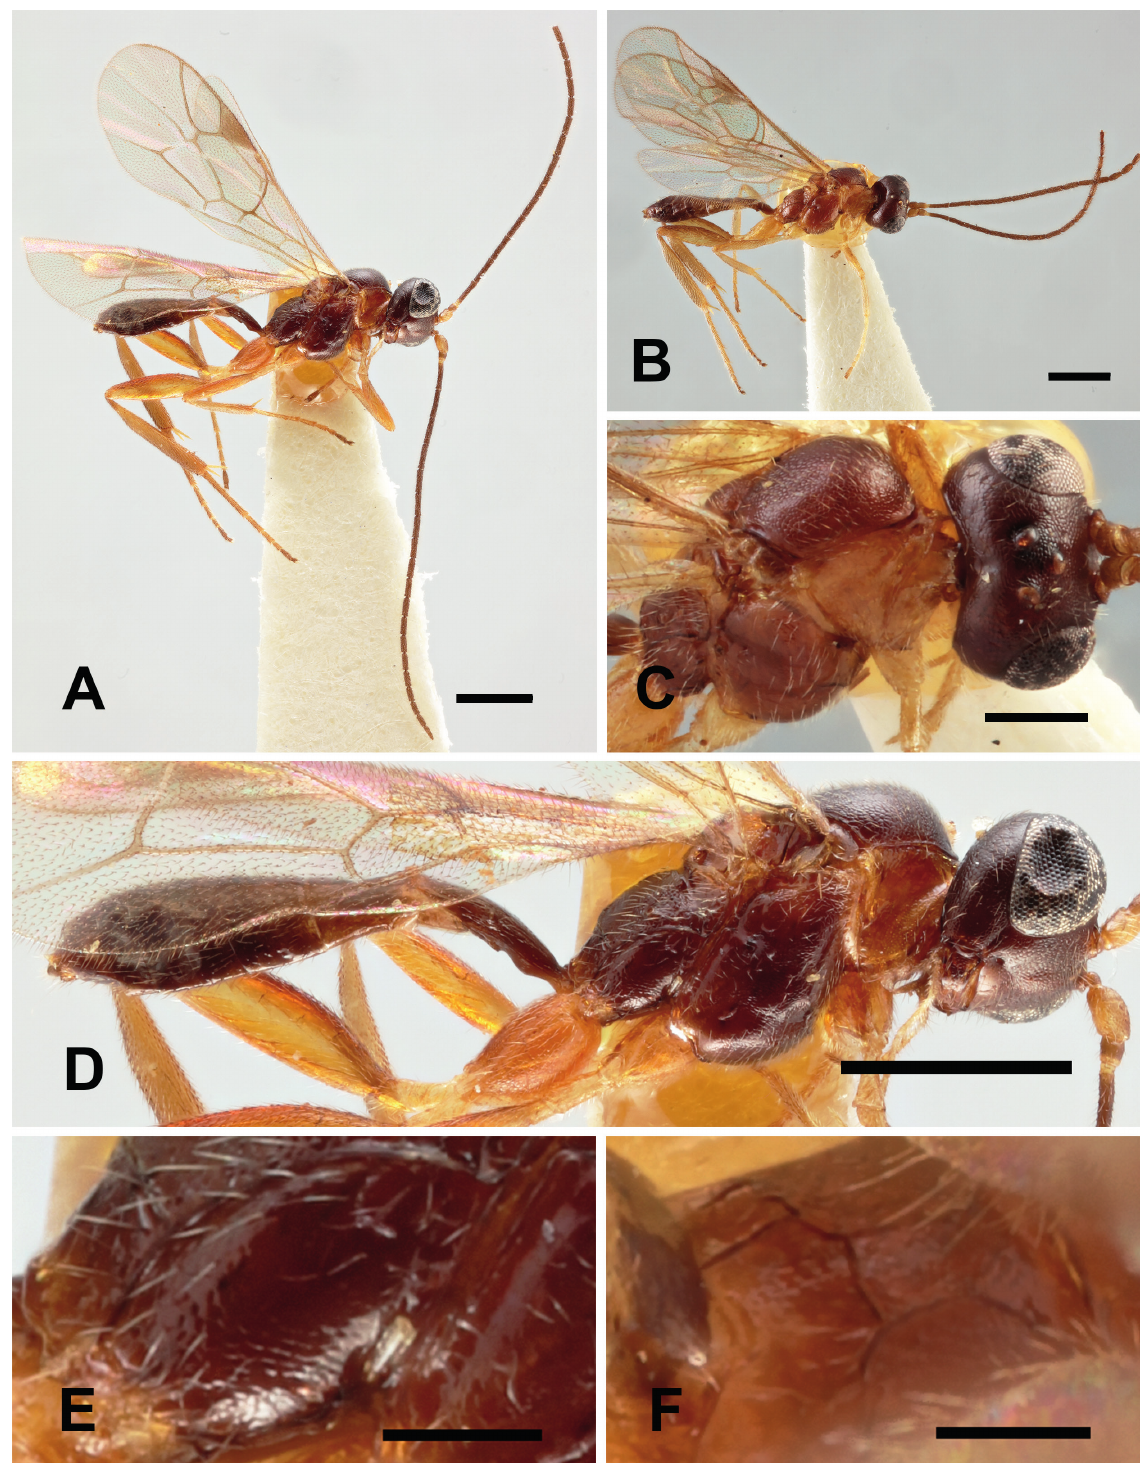
Fig. 6. Morphology of Handaoia plaumanni sp. nov. A . Habitus, lateral view, paratype, ♂ (NHMUK010636385). B . Habitus, lateral view, paratype, ♂ (NHMUK010636384). C . Head and mesosoma, dorsolateral view, paratype, ♂ (NHMUK010636384). D . Habitus, lateral view, paratype, ♂ (NHMUK010636385). E . Metapleuron, paratype, ♂ (NHMUK010636385). F . Propodeum, dorsal view, paratype, ♂ (NHMUK010636384). Scale bars: A–B = 0.5 mm; C–D = 0.2 mm; E–F =